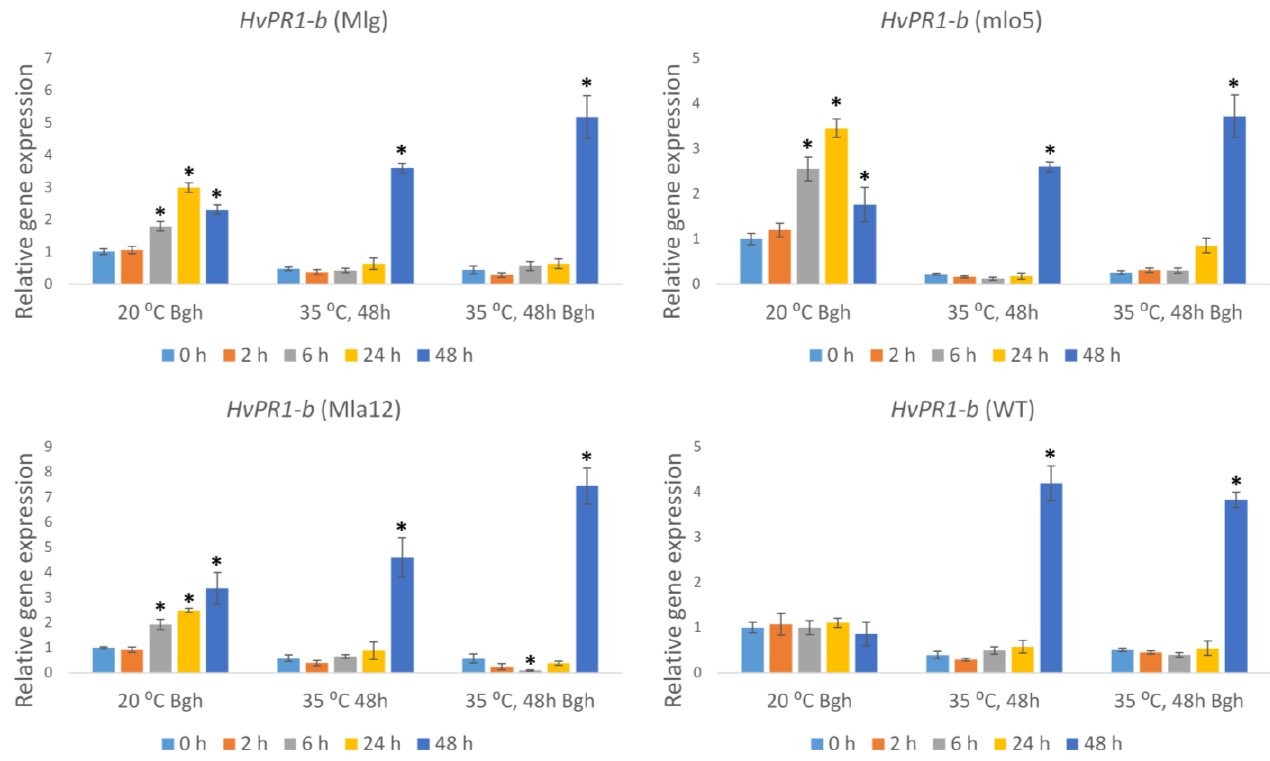
Figure 4. Expression of the barley Pathogenesis related-1b ( HvPR1-b ) gene as detected by RT-qPCR in resistant (Mlg, mlo5, Mla12) and susceptible (WT) Hordeum vulgare cv. Ingrid near-isogenic lines at early time points (0 h, 2 h, 6 h, 24 h, and 48 h) following powdery mildew ( Blumeria graminis f. sp. hordei A6, Bgh) inoculation and/or heat stress. Heat stress treatments at 35 °C for 48 h were applied immediately before Bgh inoculation. Inoculated but not heat-treated (20 °C Bgh) and heat-treated but not inoculated (35 °C for 48 h) plants were used as controls. The graphs show the average of three experiments. Error bars represent standard deviation. Asterisks ( * ) indicate statistically significant differences from 0 h for each specific treatment at p < 0.05.